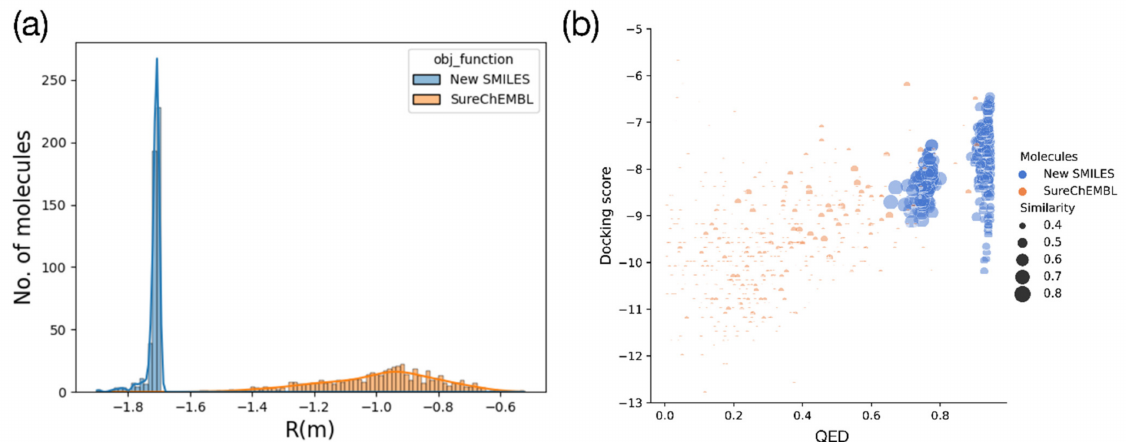
Figure 5. Comparison of ( a ) objective function values in the SureChEMBL dataset with generated molecules, ( b ) the distribution of docking energy, QED, and similarity. The yellow distribution is the SureChEMBL dataset, for 500 molecules with the highest similarity. Blue is a molecule generated using MolFinder. We can see that the generated molecules have a low objective function value distribution between − 1.6 and − 1.8 and are optimized for the desired properties. The objective function distribution of the SureChEMBL dataset has a value between − 0.6 and − 1.5, and a higher distribution than the generated molecules. In the figure on the right, the size of the circle denotes similarity, and a larger circle indicates higher similarity to the reference molecule. The x -axis is QED, and the y -axis is docking energy. The QED of the generated molecule has a much higher value than the SureChEMBL dataset. Since the docking energy is optimized by considering similarity, we can see that it is optimized near − 8.5 kcal which is the docking energy of